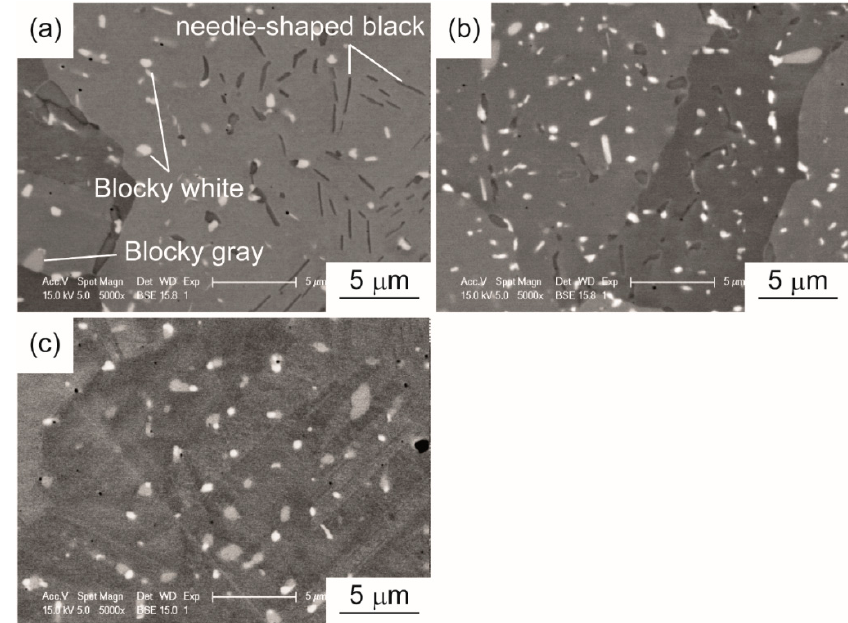
Figure 5. SEM-BSE images of the ( a ) as-built, ( b ) aged, and ( c ) reversely transformed specimens of the low-C alloy.